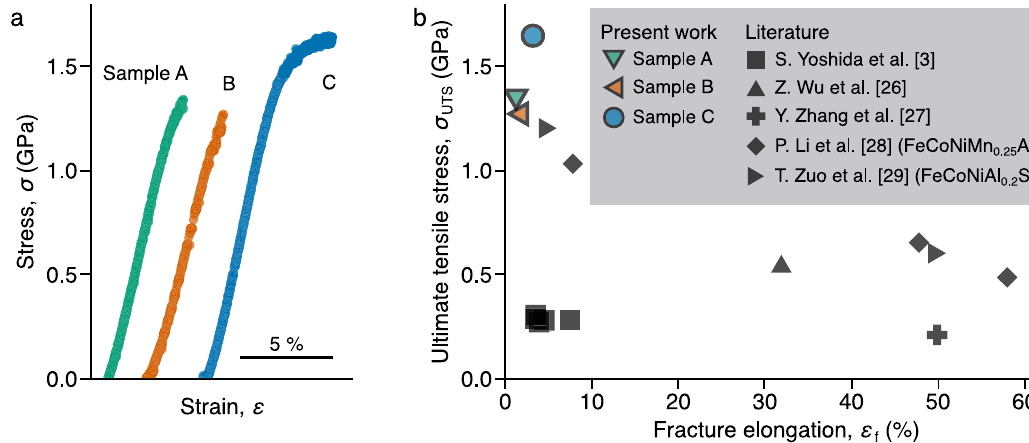
Figure 3. Mechanical properties of the electrodeposited nanocrystalline FeCoNi MEAs. ( a ) Stress–strain curves of samples A, B, and C. ( b ) UTS and fracture elongation in this work compared with the literature 3,26–29 .